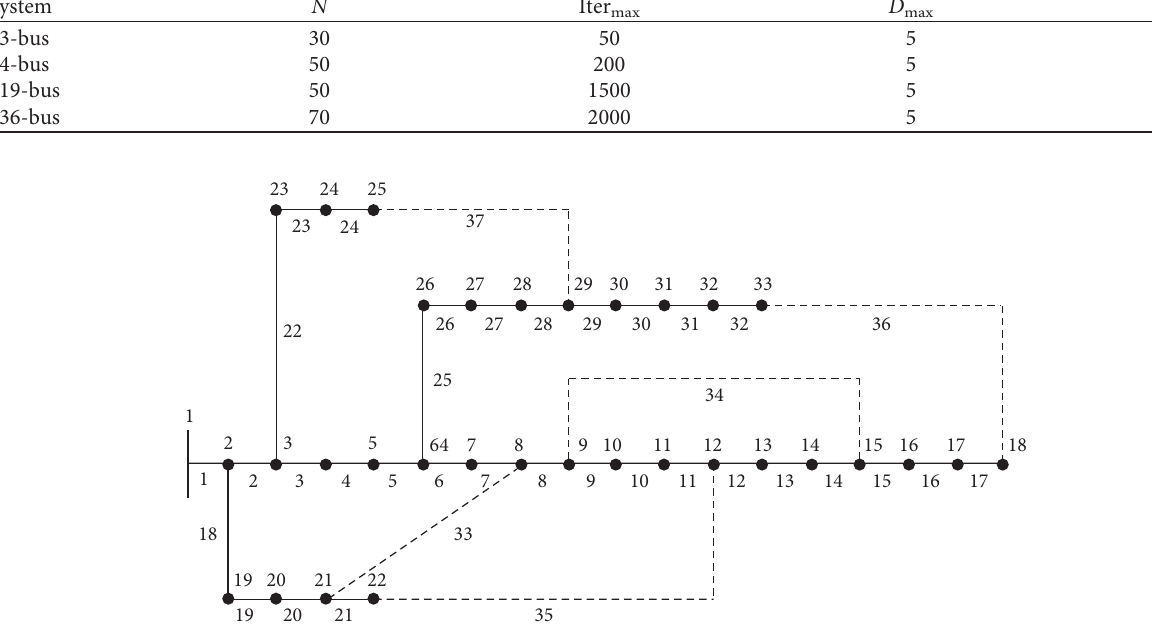
Figure 1: Single-line diagram of the 33-bus system. Table 2: Result comparison of CSFSA with other methods for the 33-bus system.